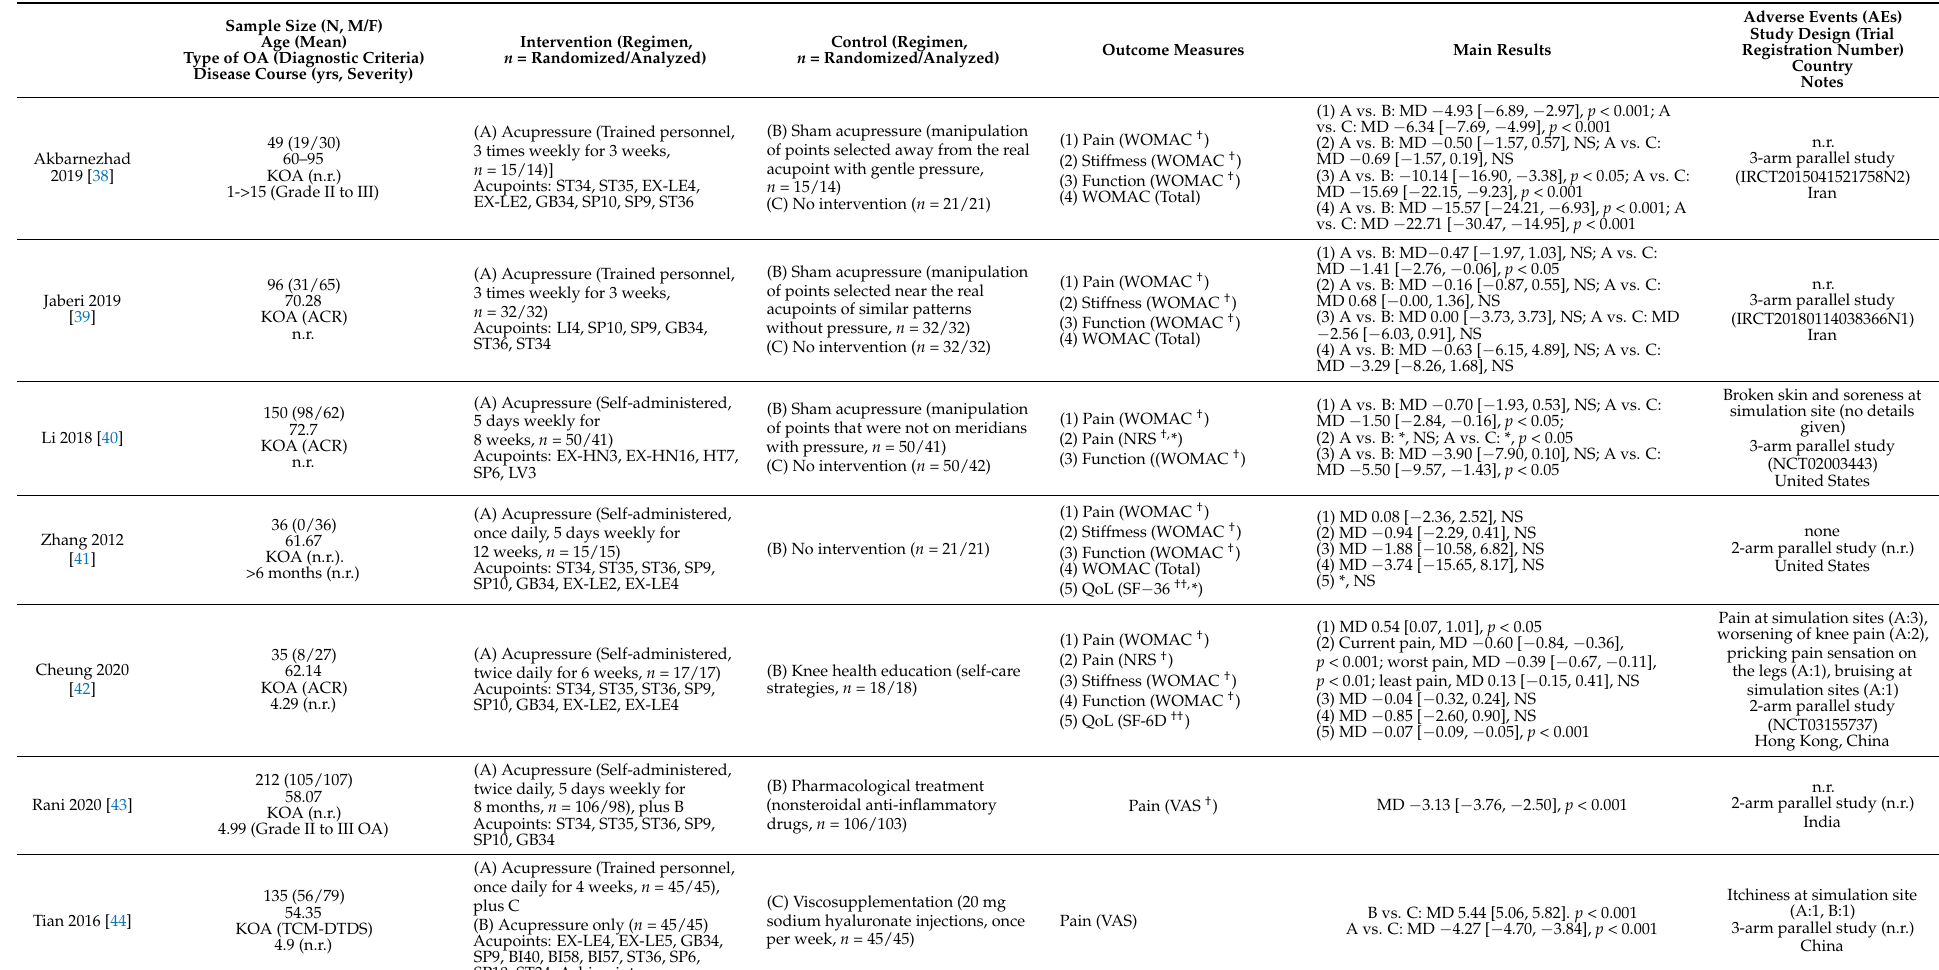
Table 1. Summary of included